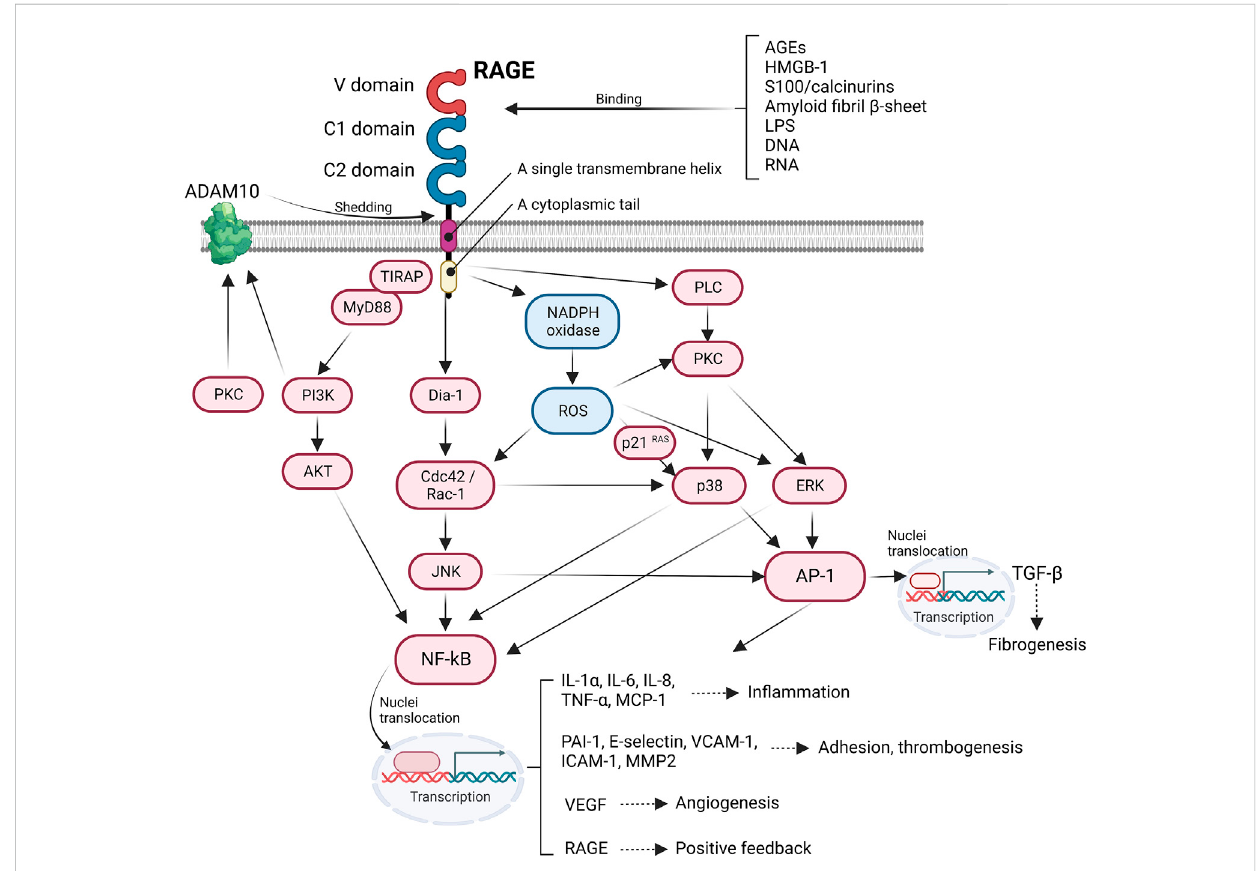
FIGURE 1 Intracellular RAGE signaling. The engagement of RAGE with several ligands including AGEs, HMGB-1, S100/calcinurins is involved in pro fi brotic and in fl ammatory response, cell adhesion, angiogenesis, and